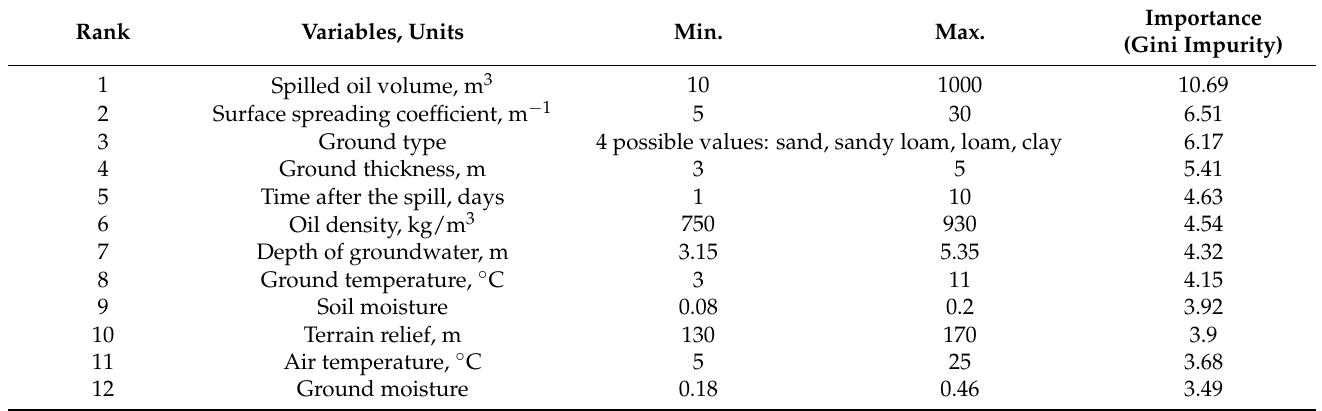
Table 2. An initial set of variables for predicting the impact of an oil spill on the ground environ- ment.